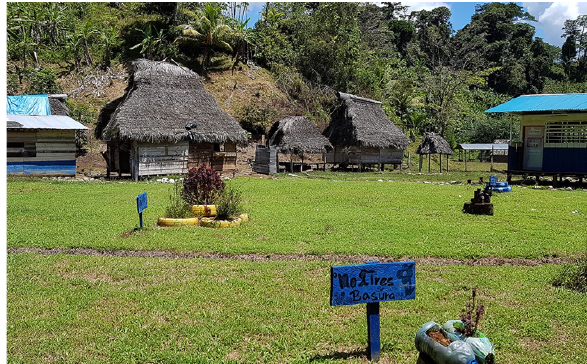
Figure 3. Primary school in Los Santos, Ngäbe territory.